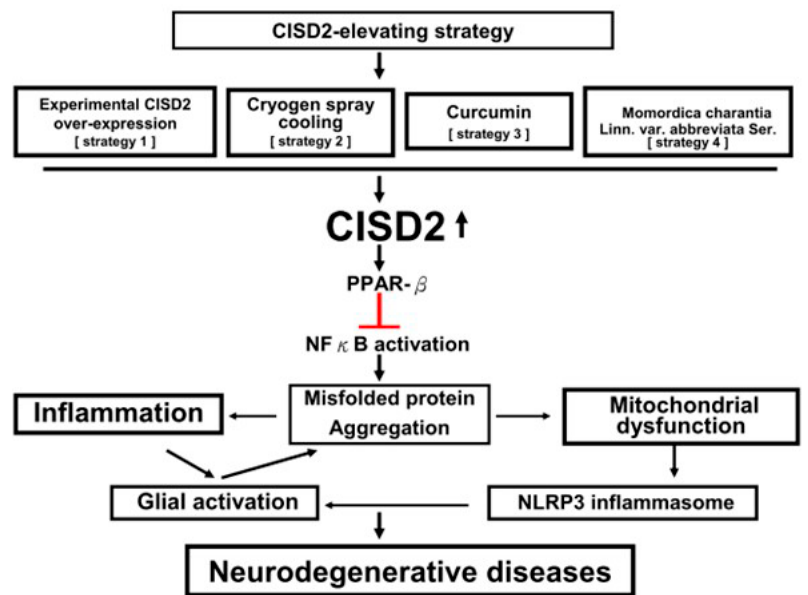
Figure 1. Diagram of the benefit of CISD2-elevating strategies in neurodegenerative diseases (NDs). NF κ B-provoked inflammation and mitochondrial dysfunction underlie the pathogenesis of NDs. Accumulation of misfolded proteins in the central nervous system (CNS) induces neuroinflammation by triggering the activation of microglia, astrocytes, and glia-secreted proinflammatory cytokines/chemokines. Advanced neuroinflammation consequently leads to mitochondrial dysfunction and the production of mitochondrial damage-associated molecular patterns (DAMP), which promote the activation of NLRP3 inflammasome and subsequently exaggerate neuroinflammation. Through association with PPAR- β and prevention of I κ B degradation, CISD2 can inhibit NF κ B activation (red bar). Therapeutic strategies that upregulate CISD2 have the potential to attenuate the PPAR- β /I κ B/NF κ B signaling pathway and mitigate NF κ B-provoked inflammation and mitochondrial dysfunction implicated in NDs.